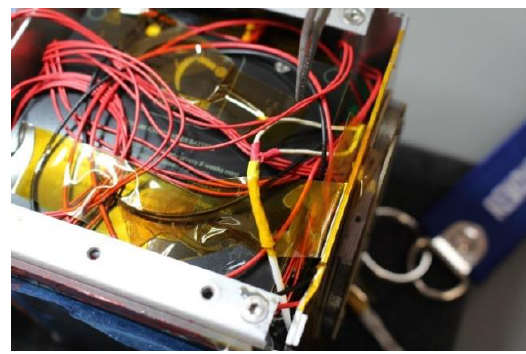
Figure 14. Picture from the final integration of